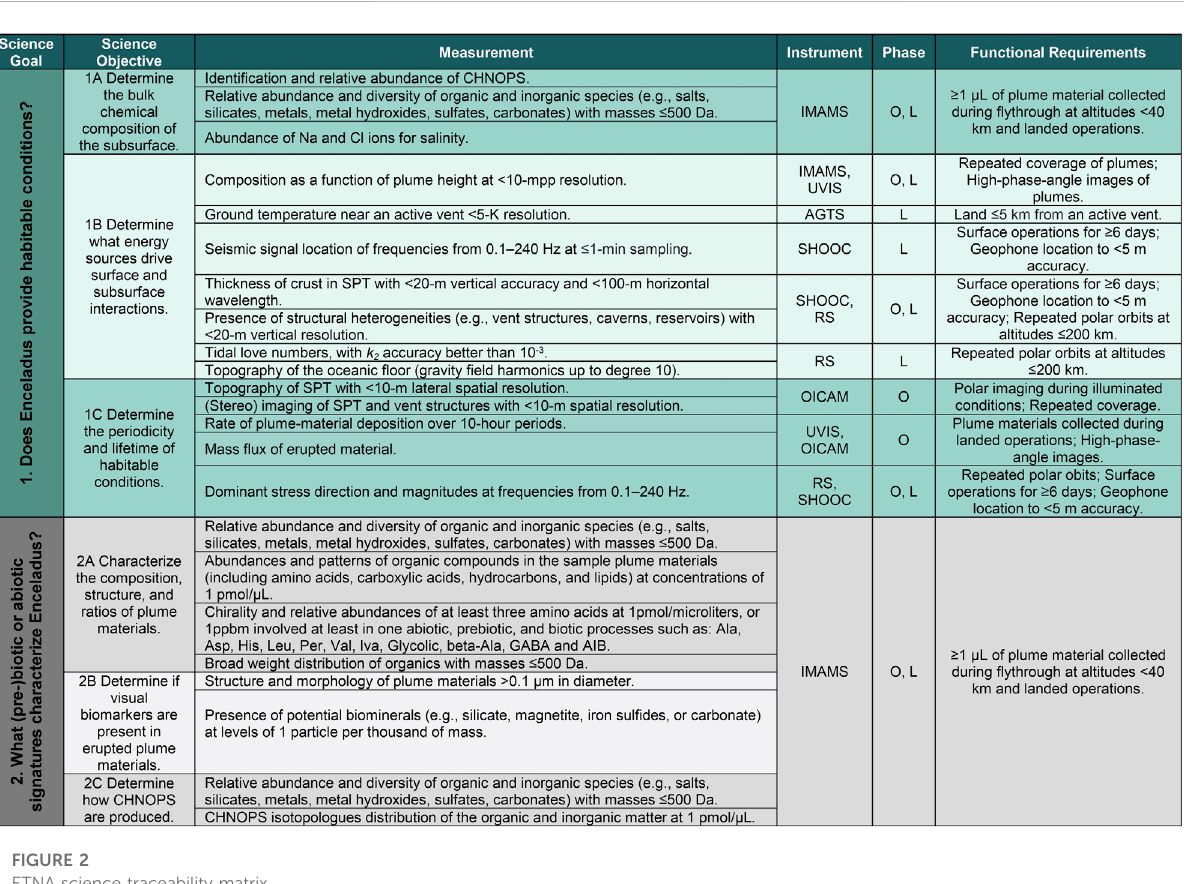
FIGURE 2 ETNA science traceability